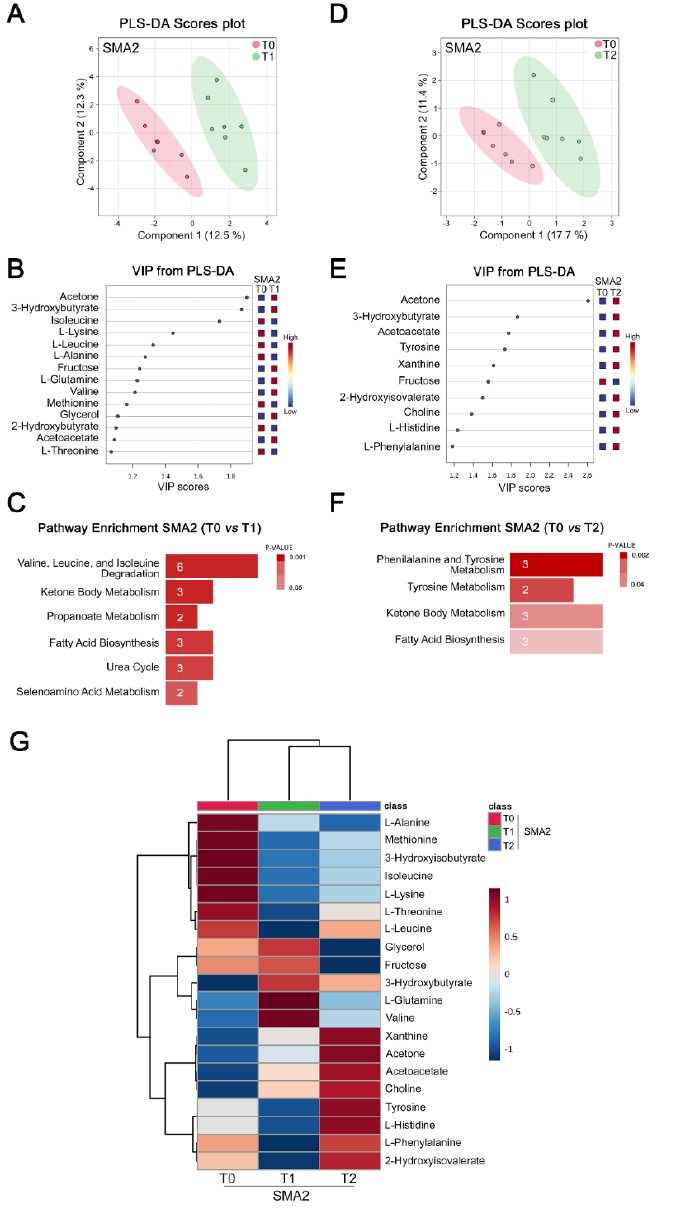
Figure 4. Nusinersen modulates amino acid and ketone body metabolism in the CSF of SMA2 patients. ( A , D ) PLS-DA score scatter plots showing the metabolomic profile of CSF from SMA2 patients before treatment (T0) and at loading (T1) ( A ) or maintenance (T2) ( D ) phases of Nusinersen administration. The clusters’ analyses are reported in the Cartesian space that is described by the main components, PC1: 12.5% and PC2: 12.3% (T0 vs. T1 clusters) ( A ) and PC1: 17.7% and PC2: 11.4% (T0 vs. T2 clusters) ( D ). PLS-DA was evaluated using cross validation (CV) analysis. CV tests